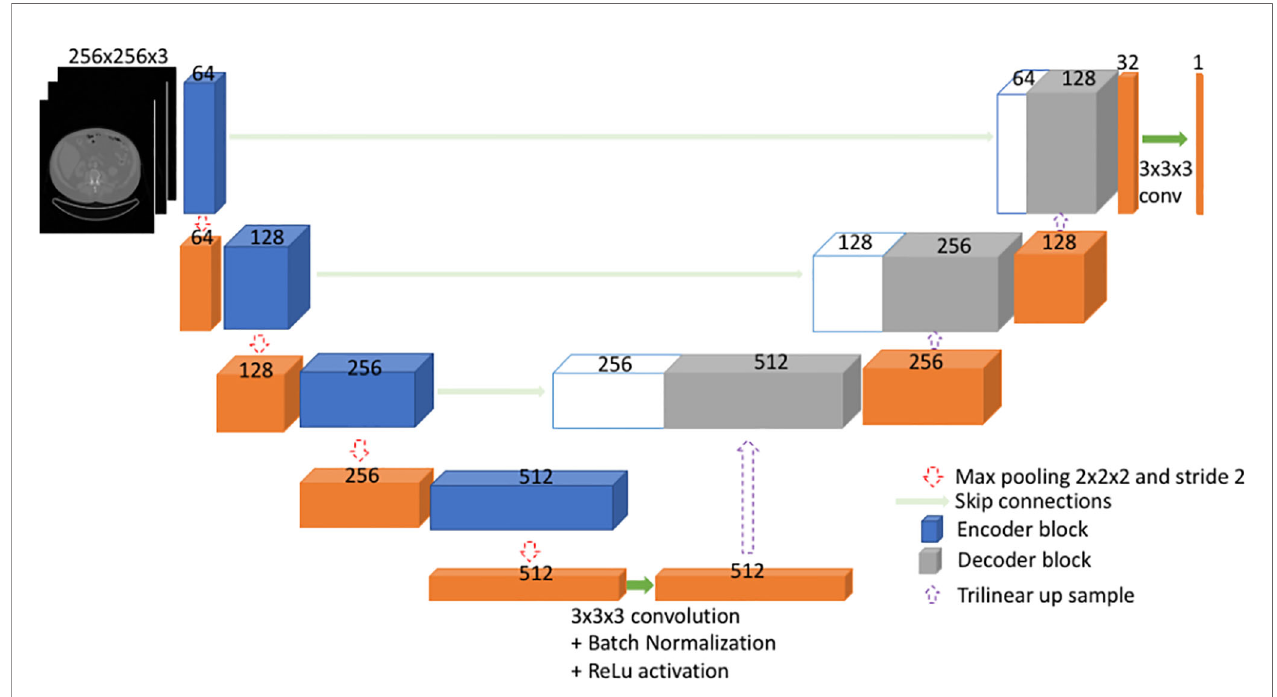
FIGURE 1 | 2.5D U-Net like architecture used in the current